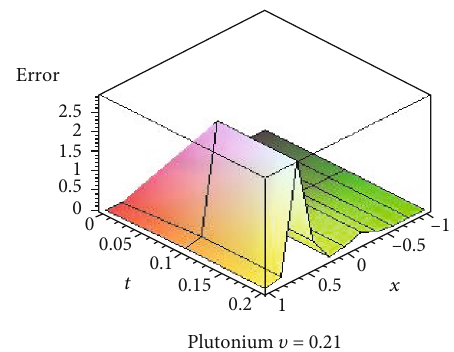
Figure 17: The value absolute error by PNM at N = 20 and T = 0 : 2